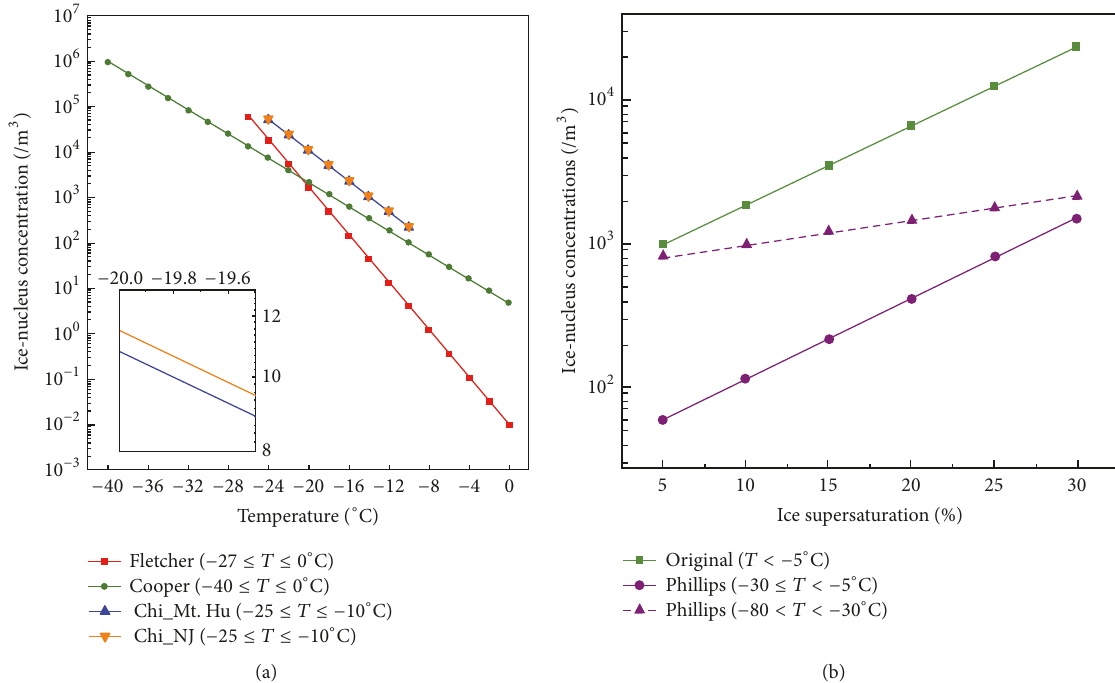
Figure 1: Variation of the ice nuclei concentration (unit: L −1 ) depending on the activation temperature; (a) 𝑇1 and 𝑇2 groups (unit: ∘ C) and ice surface supersaturation; (b) 𝑆 group (unit: